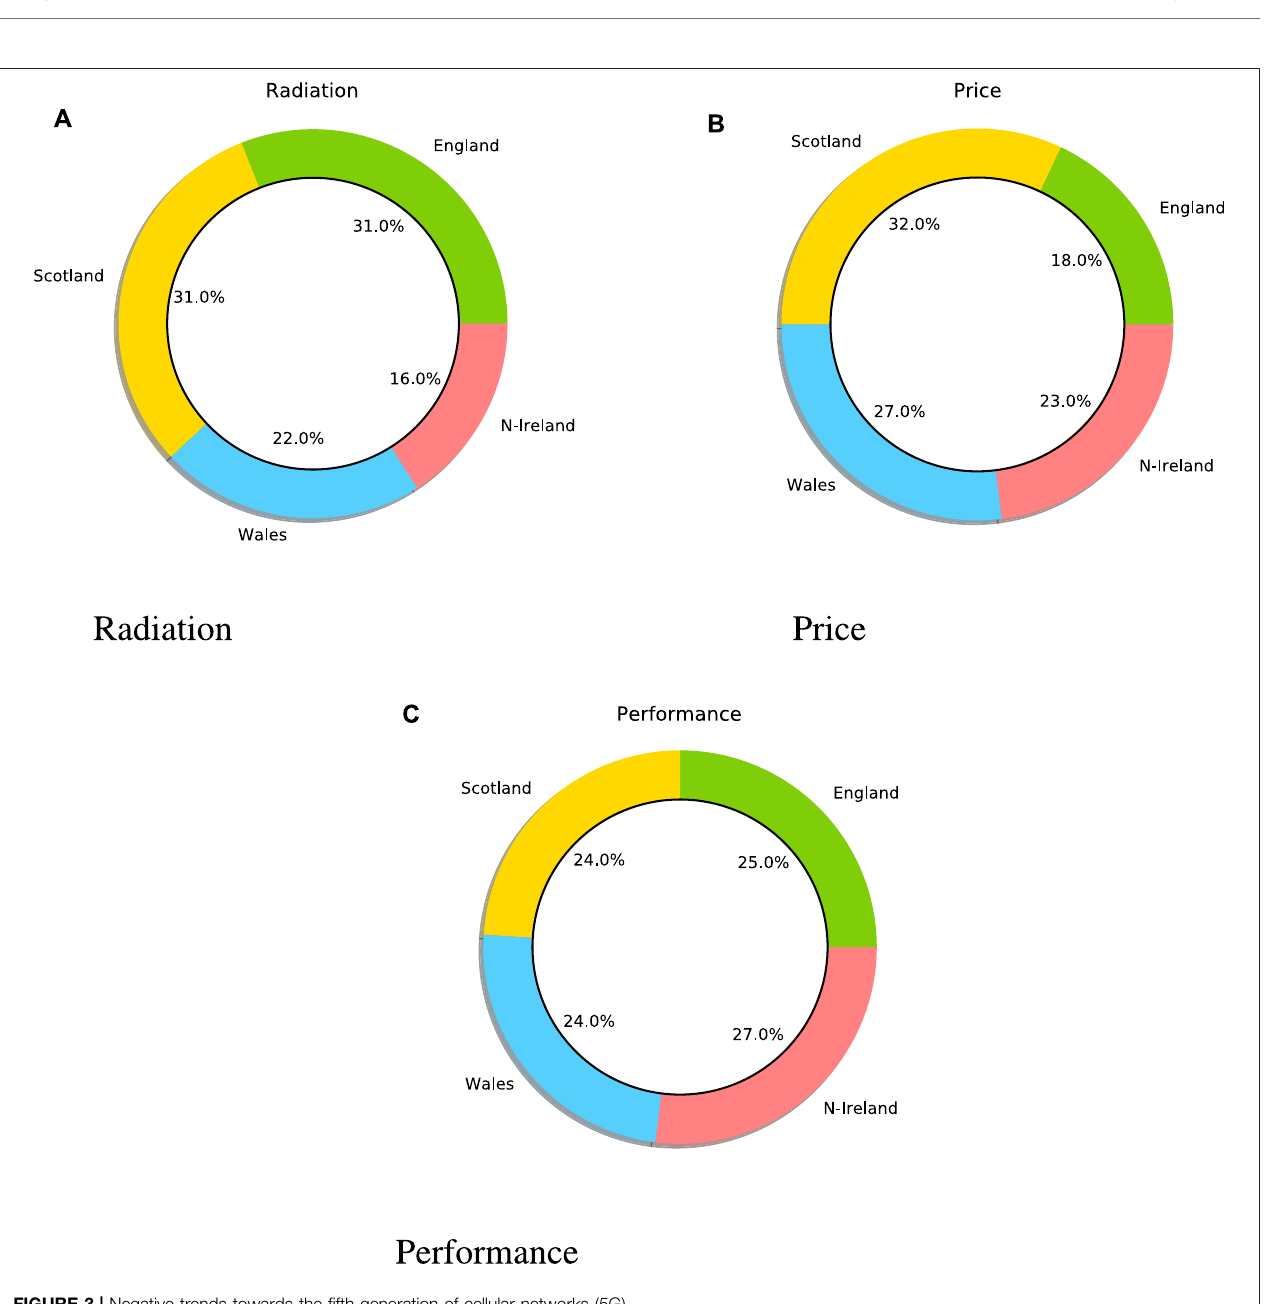
FIGURE 3 | Negative trends towards the fi fth generation of cellular networks